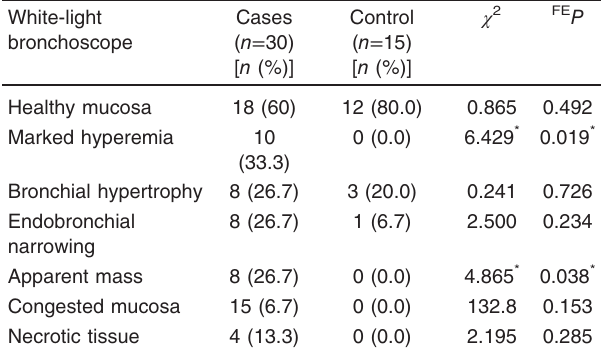
Table 3 Comparison between the two groups studied according to white-light bronchoscope White-light